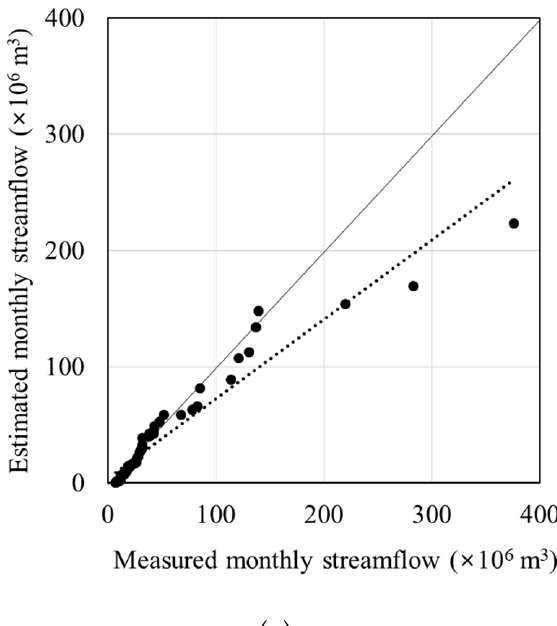
Figure 5. Scatter plots of measured and estimated monthly streamflows during validation: ( a ) Wsd-01; ( b ) Wsd-02; ( c ) Wsd-03; ( d ) Wsd-04; ( e ) Wsd-05; ( f ) Wsd-06; ( g ) Wsd-07; ( h ) Wsd-08; ( i ) Wsd-09; ( j ) Wsd-10; ( k ) Wsd-11; ( l ) Wsd-12; ( m ) Wsd-13; ( n ) Wsd-14; and ( o ) Wsd-15.